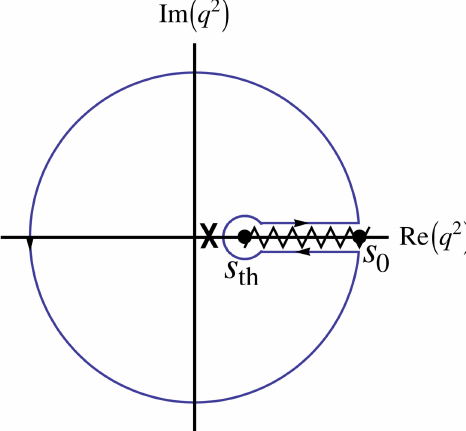
Im Π L + T ( s ) . ud,V/A π